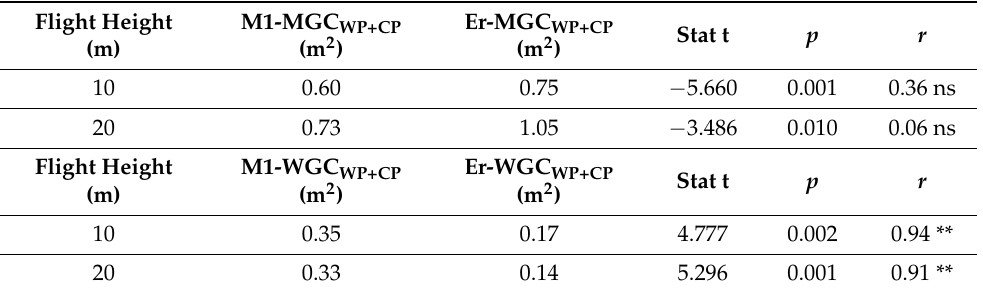
Table 3. Maize green cover and weed green cover on weeded and control plots (WP and CP) Er-WGC WP+CP ). Student t -test, p -value and Pearson correlation coefficient ( r ). Flight